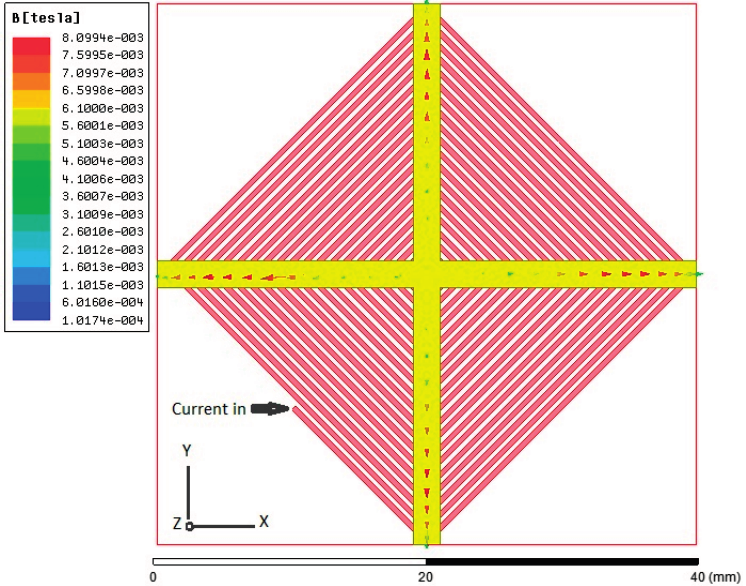
Figure 6. A 3-D model of a planar excitation coils and its simulated result with a 2-mm cruciform ferromagnetic core under the excitation current of 5 A.